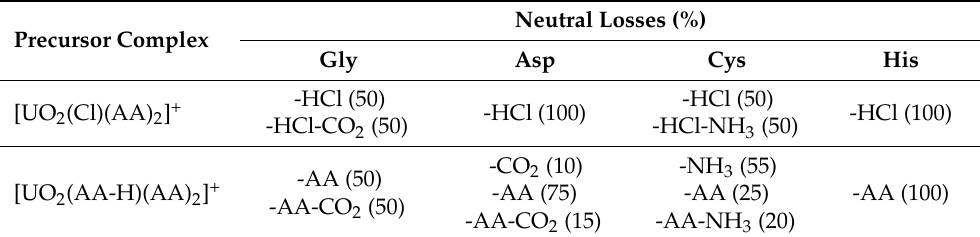
Table 1. CID of cationic uranyl–amino acid